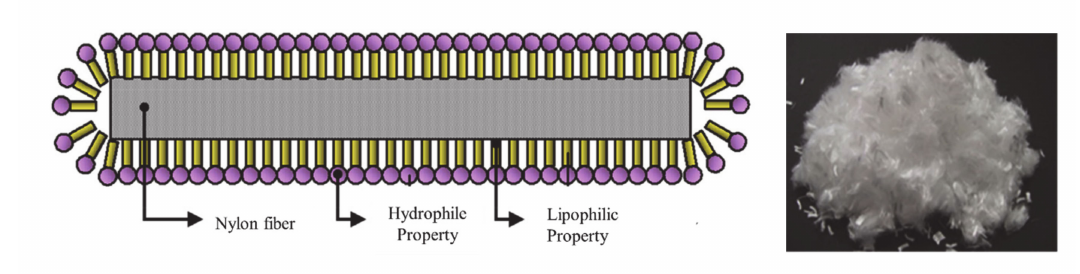
Figure 15. Surface coating of the nylon